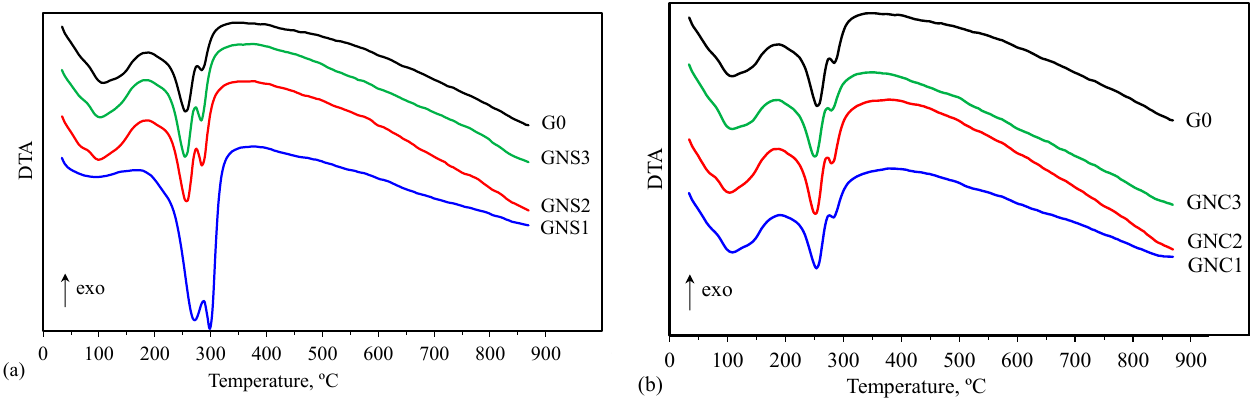
Figure 12. DTA curves for cement pastes containing NS ( a ) and NC ( b ).